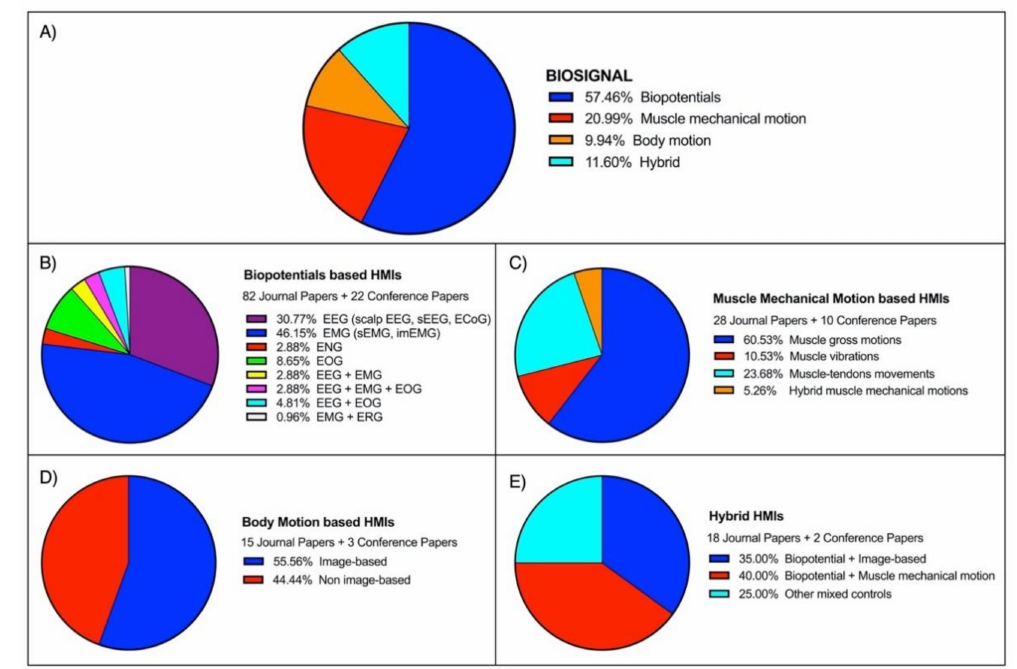
Figure 3. ( A ) Pie chart showing the percentage distribution of the biosignals implemented by the HMIs considered in this survey. ( B – E ) Pie charts representing the percentage distributions of the biosignals subcategories: ( B ) Biopotentials-based HMIs; ( C ) Muscle mechanical motion-based HMIs; ( D ) Body motion-based HMIs; ( E ) Hybrid